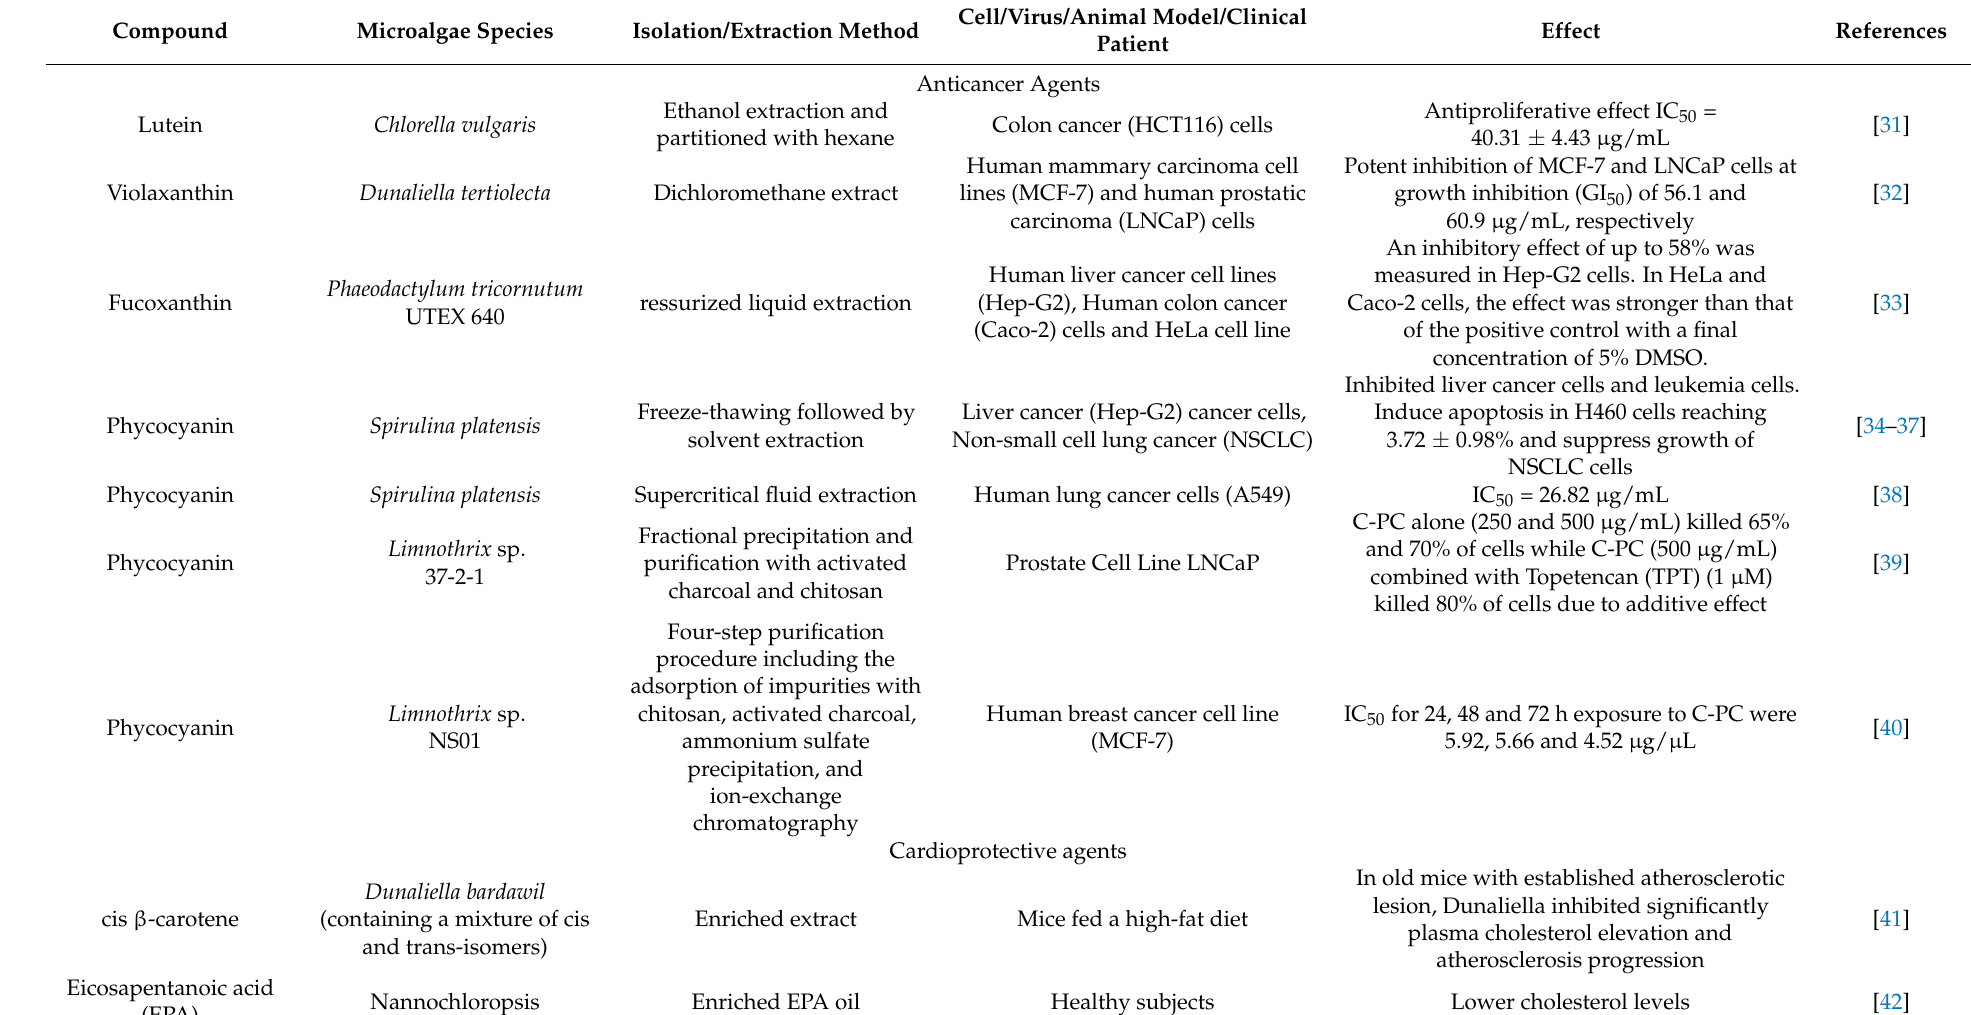
Table 1. Important micro-algae derived components in pharmaceutical